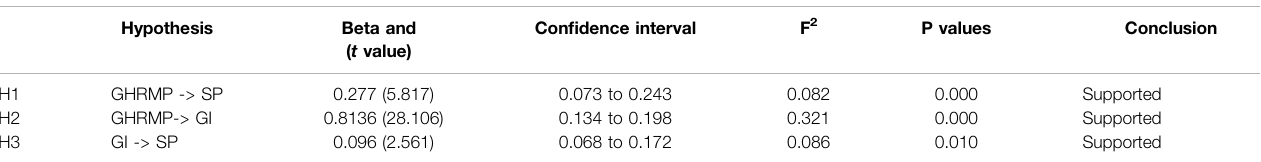
TABLE 4 | Hypothesis testing.